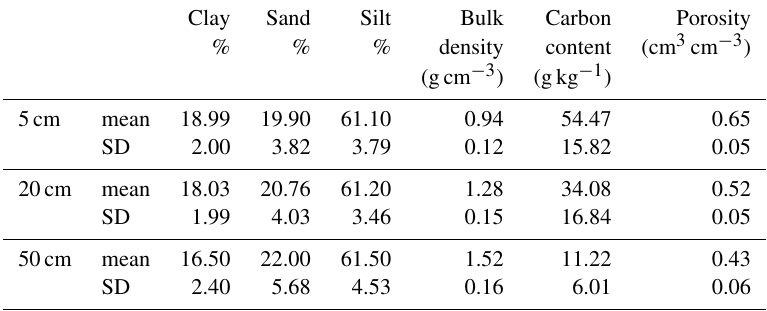
Table 2. Descriptive statistics of soil properties determined from 273 soil samples taken in the Rollesbroich catchment. Clay Sand Silt Bulk Carbon